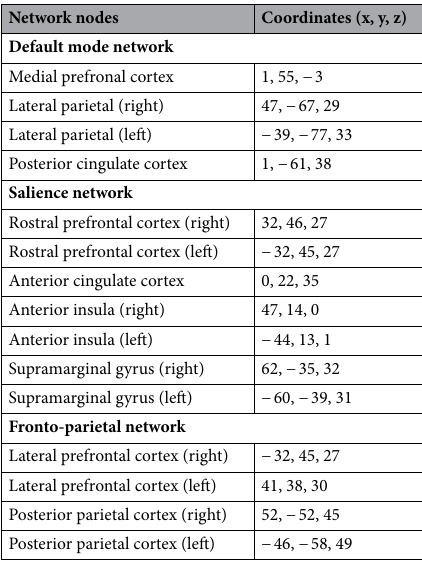
Table 1. Network assignment and coordinates for network